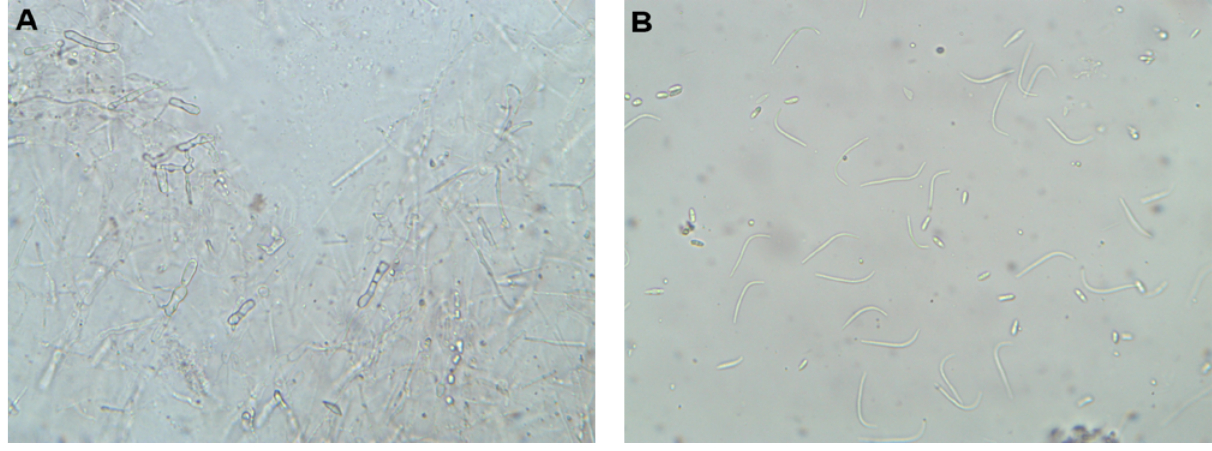
Fig. 6 Degradation of Diaporthe eres hyphae ( A ) and the prevalence of beta-type conidia ( B ) in cultures growing in the presence of Beta-Chikol at the concentration of 2% (photo B.